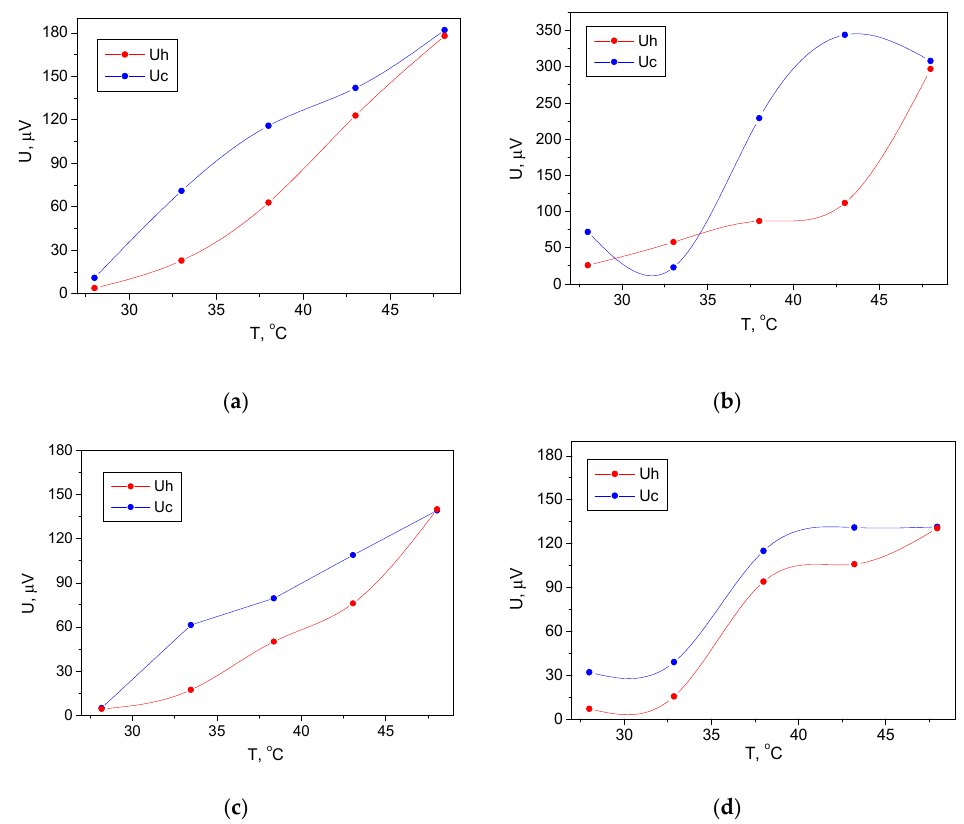
Figure 5. Pyroelectric response of silicon/Ag/BST/PVDF-TrFE/devices with ( a ) in-plain design; ( b ) out-of-plain design; ( c ) single layer coating of ferroelectric oxide with in-plain electrodes; ( d ) single layer coating of pyroelectric ink with in-plain electrodes. Uh—the measured voltage at the sample heating; Uc—the measured voltage at the sample cooling.